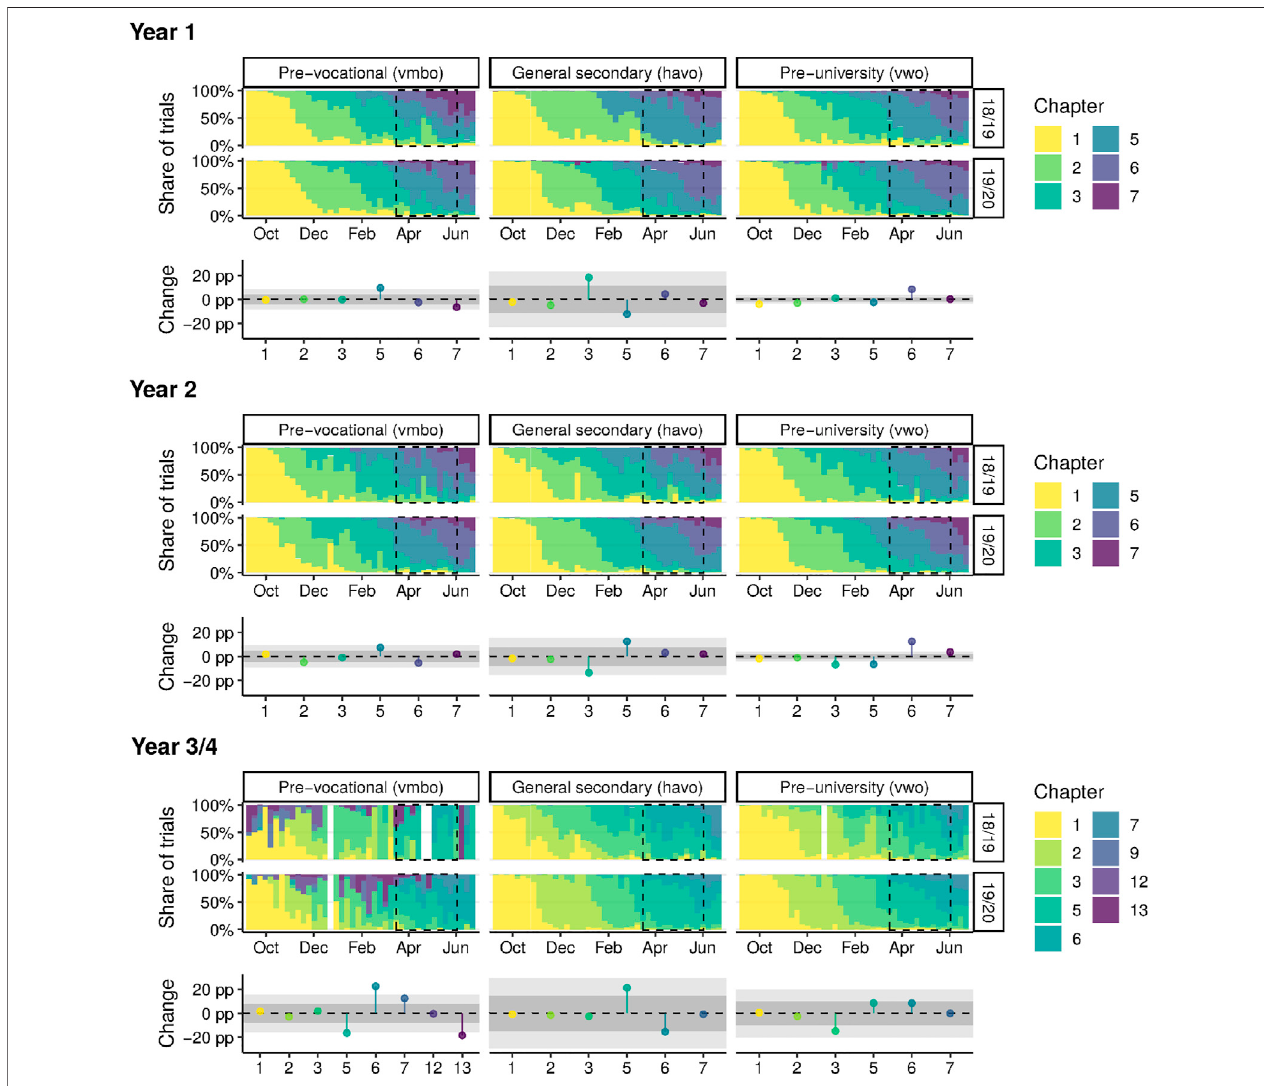
FIGURE3| ProgressthroughtheFrenchmaterialsovertime:theshareofstudytrialspertainingtoeachtextbookchapterasapercentageofalltrialscompletedina week. The school closure period in the 19/20 school year and the corresponding period in the previous year are marked by a dashed border. The change in trial share during this period is shown, per chapter, below each set of plots, where the dark-grey and light-grey bands indicate the variability between the two school years in the period preceding the lockdown (1 SD and 2 SD, respectively).